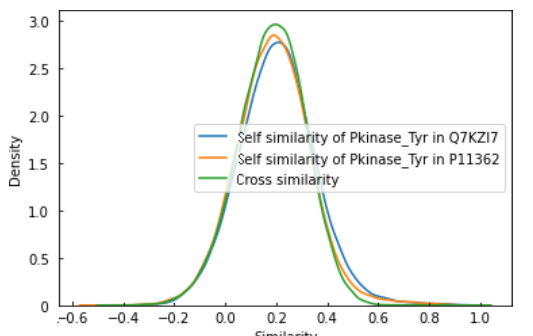
Fig. 5 Example of slice similarity distribution of different domains.